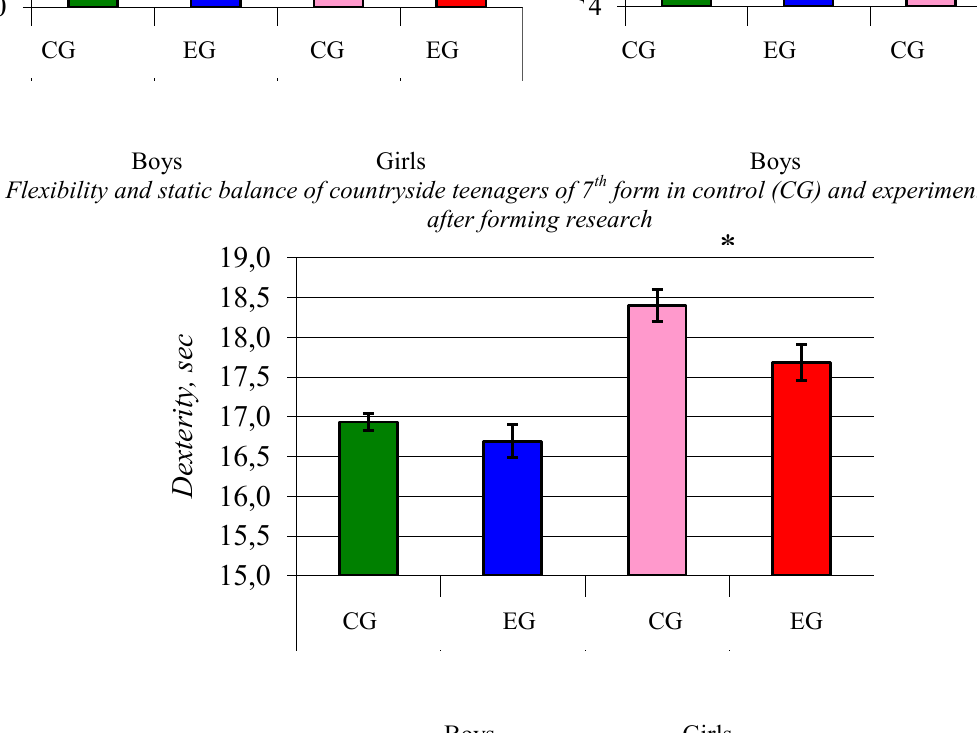
Boys Girls Fig.4 Dexterity of countryside teenagers of 7 th form in control (CG) and experimental (RG) groups after forming research by test “Shuttle run